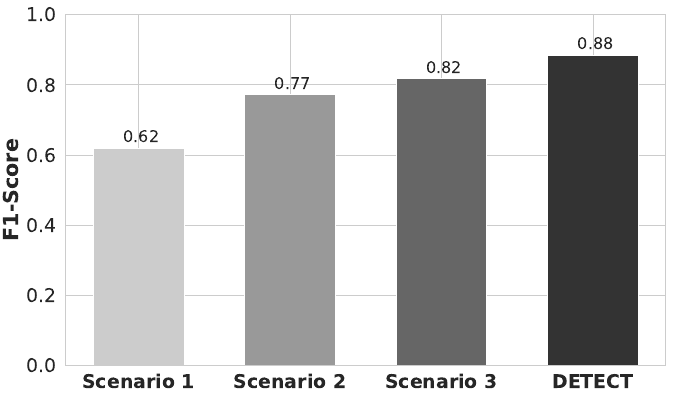
Figure 10. F1-score results for each scenario of data improvement.